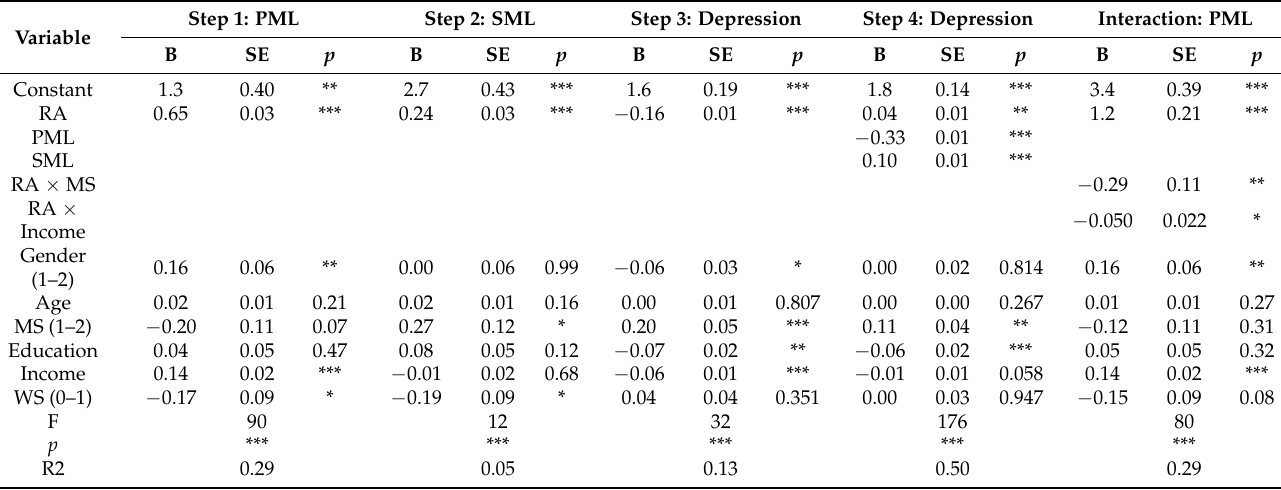
Table 4. Direct and interaction analyses.